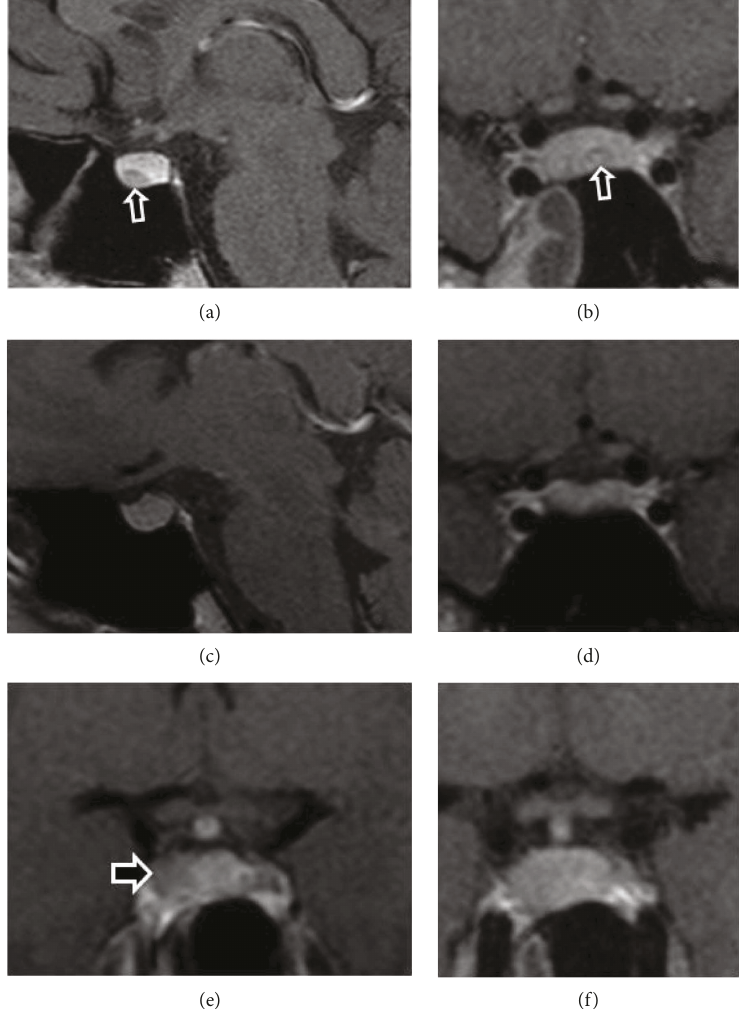
Figure 2: Pituitary MRI scans of the proband ’ s sister (case 3), showing a Rathke ’ s cleft cyst when fi rst screened at the age of 17 (a, b), which completely disappeared in the following 5 years (c, d). A 4mm microadenoma became visible in the right side (e) of her bulky pituitary